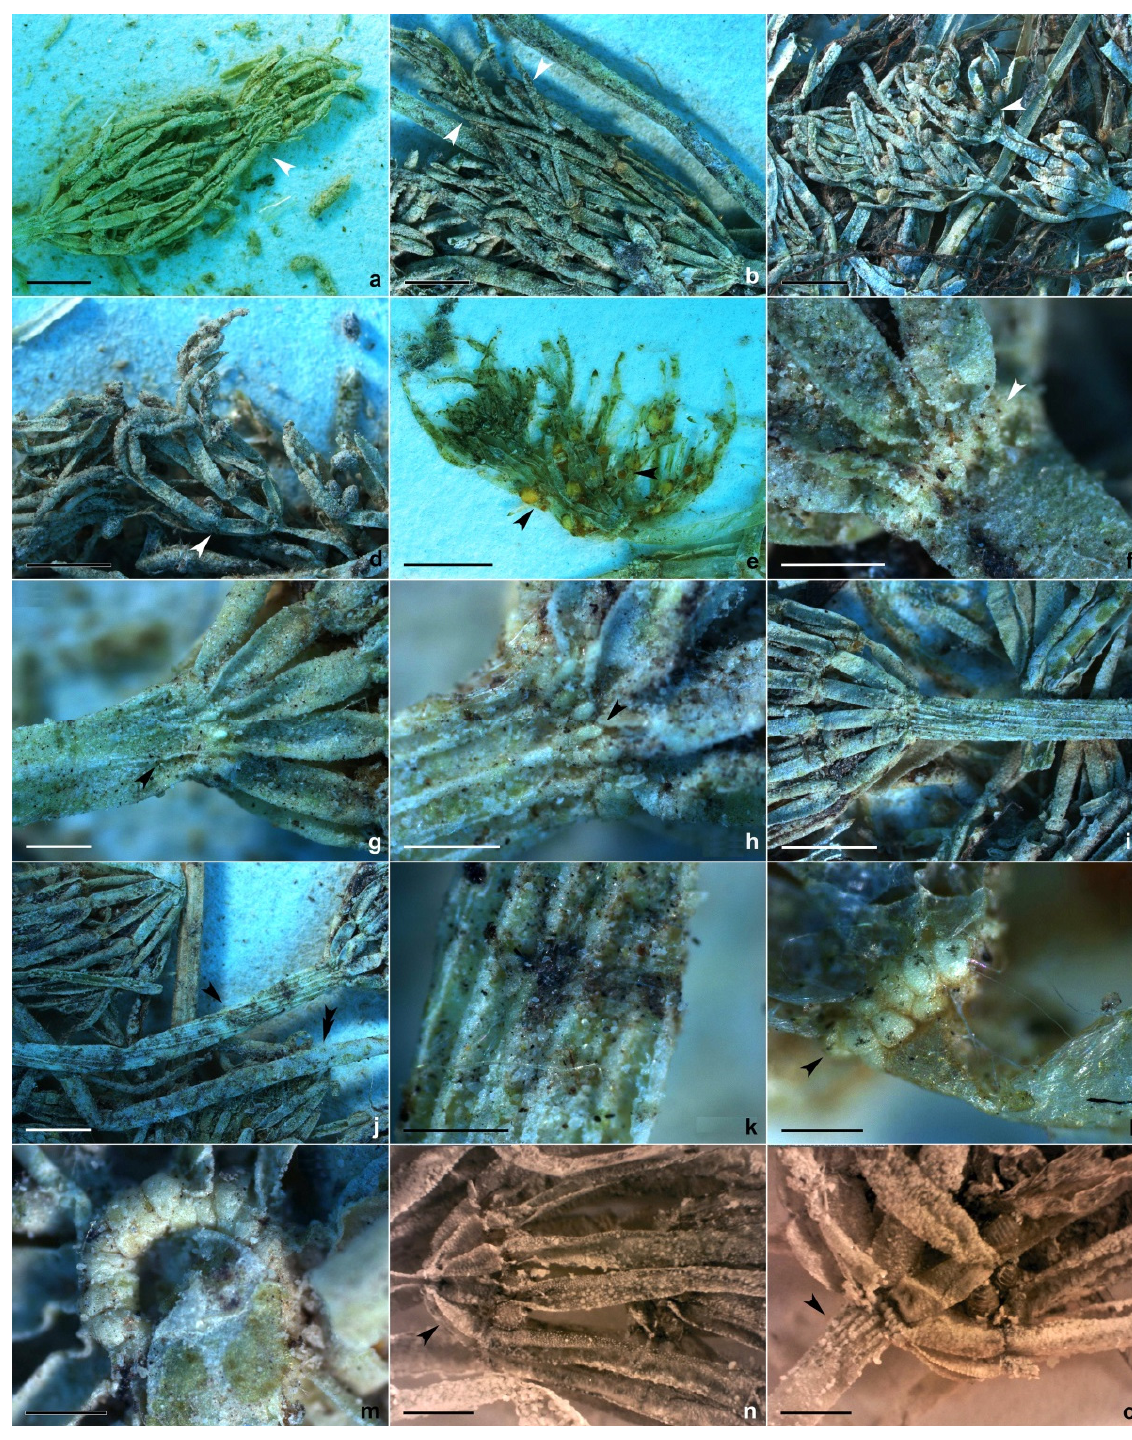
Figure 1. Chara denudata : ( a–m )—the isolectotype from South Africa (LE); ( n , o )—a specimen from Oman (B); ( a )—apical part with branchlets having long adaxial bract cells, the arrowhead indicates the unbroken long undifferentiated ecorticate end of a branchlet; ( b )—differentiated part of the branchlet, arrowheads indicate long adaxial bract cells; ( c , d )—apical part with short ( c ) and very short ( d ) adaxial bract cells, arrowheads indicate fertile branchlet node; ( e )—upper part of plant after decalcification with acid and subsequent pressing, probably implemented by Hollerbach, arrowheads indicate conjoined gametangia; ( f )—base of branchlet whorl, arrowhead indicates hardly recognizable short stipulodes; ( g )—base of branchlet whorl and stem section below it with narrow elongated incompletely developed primary tubes of the stem cortex (arrowhead); ( h )—base of branchlet whorl and stem section below it with narrow elongated primary tubes of the stem cortex with wide empty spaces between them, the arrowhead indicates slightly elongated diplostephanous stipulodes; ( i )—base of branchlet whorl and stem section below it with narrow and long primary tubes of the stem cortex with wide empty spaces between them; ( j )—stem sections showing narrow and long primary tubes of the stem cortex with wide empty spaces between them (arrowhead) and ecorticate internode (double arrowhead); ( k )—stem sections showing narrow and long primary tubes of stem cortex with wide empty spaces between them; ( l , m )—base of branchlet whorl with a ring-shaped nodal bulbil consisting of cells with starch grains (arrowhead at l); ( n )—base of